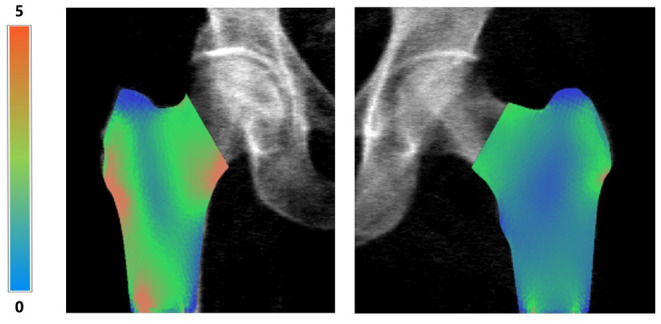
Examples of right femur BSI analysis (on the left, BMD total value = 0.55 g/cm2, Femur BSI = 2.09) and of left femur BSI analysis (on the right, BMD total value = 0.82 g/cm2, Femur BSI = 1.29) of two different patients. The heat map related to the strain distribution shows a major strain concentration on the red area. The head of the femur is not represented because the colored regions represent the same regions identified by DXA analysis (neck, intertrochanteric and trochanteric).